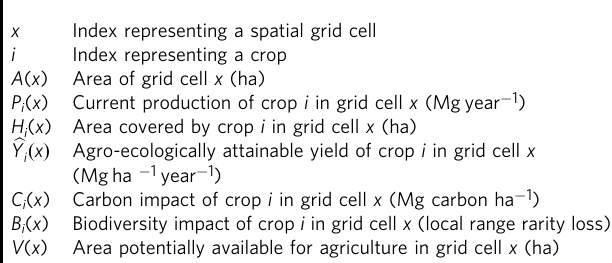
Table 1 Notation used in the description of the optimisation framework.